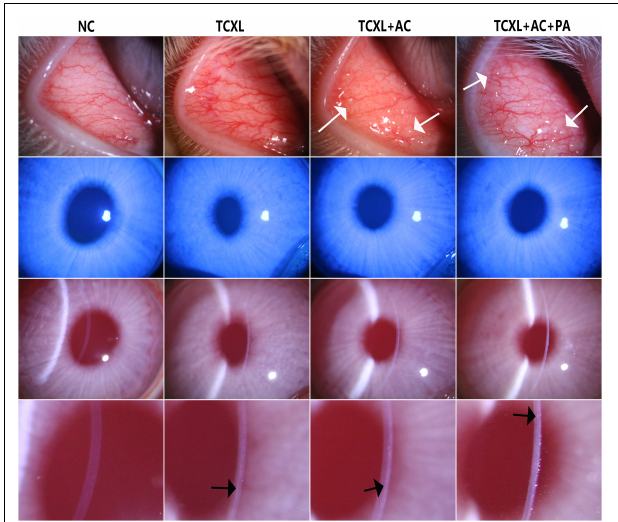
FIGURE 1 | Representative slit-lamp photographs on D28 show the palpebral conjunctival hyperemia (row 1), corneal fluorescein sodium staining (row 2), central corneal edema (row 3) and demarcation line in the anterior stroma (row 4) in different groups. The degree of conjunctival hyperemia in the TCXL + AC group was apparently higher than that in the TCXL group or TCXL + AC + PA group, while no obvious hyperemia was observed in the NC group. No obvious corneal epithelium staining or corneal edema was observed in any group on D28. The white arrows indicated the conjunctival papillae, which were the signs of allergic conjunctivitis. The black arrows indicated the clear demarcation lines in the middle stroma of TCXL and TCXL + AC + PA group, as well as an indistinct hyper-reflective structure in the superficial stroma of TCXL + AC